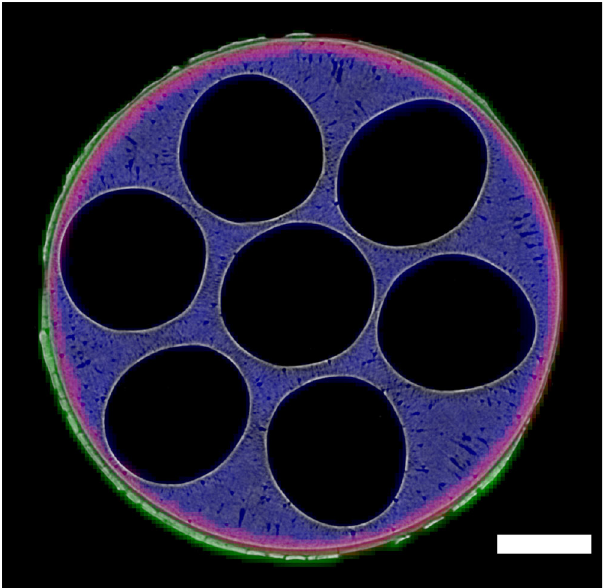
Fig. 3 Micro-computed tomography and X-ray diffraction computed tomography images. XRD-CT maps of LSM (green), YSZ (red) and NiO (blue) have been overlaid on top of a micro-CT image collected at the same z position. The scale bar corresponds to 0.5 mm